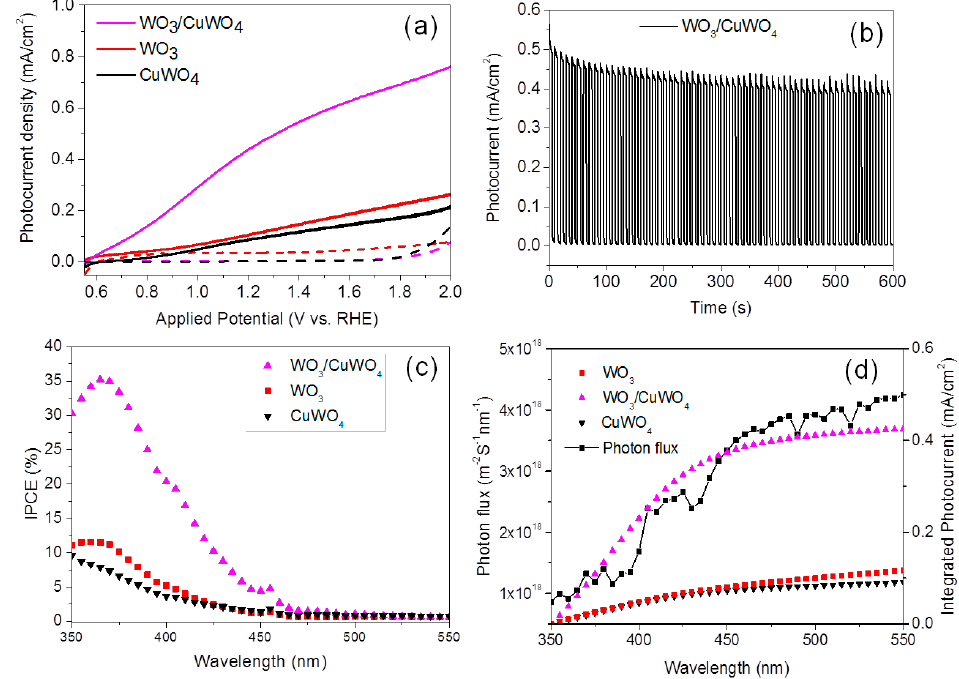
Figure 3. ( a ) Linear sweep voltammetry of WO 3 , WO 3 /CuWO 4 and CuWO 4 electrodes (solid lines: photocurrent under AM 1.5G illumination, dashed lines: dark current); ( b ) Photocurrent stability of